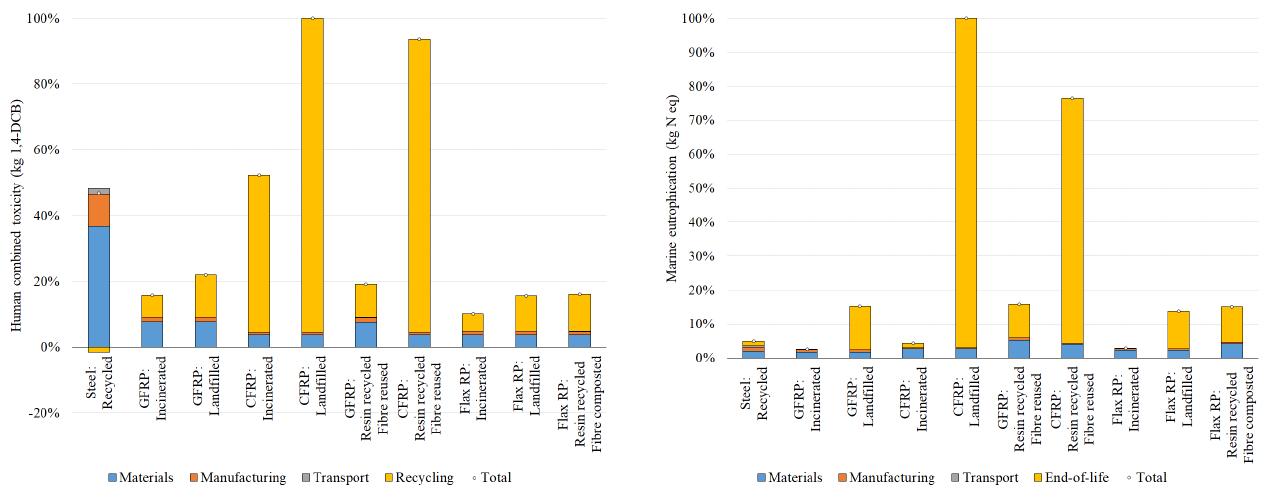
Fig. 6. Life cycle combined human health impacts for ten turbine blade material and treatment cases